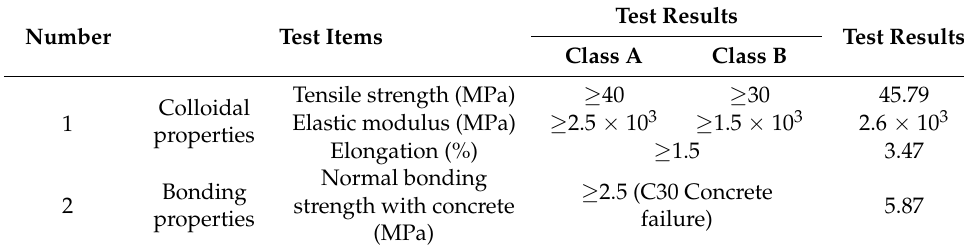
Table 4. Test results of colloid and bonding properties.